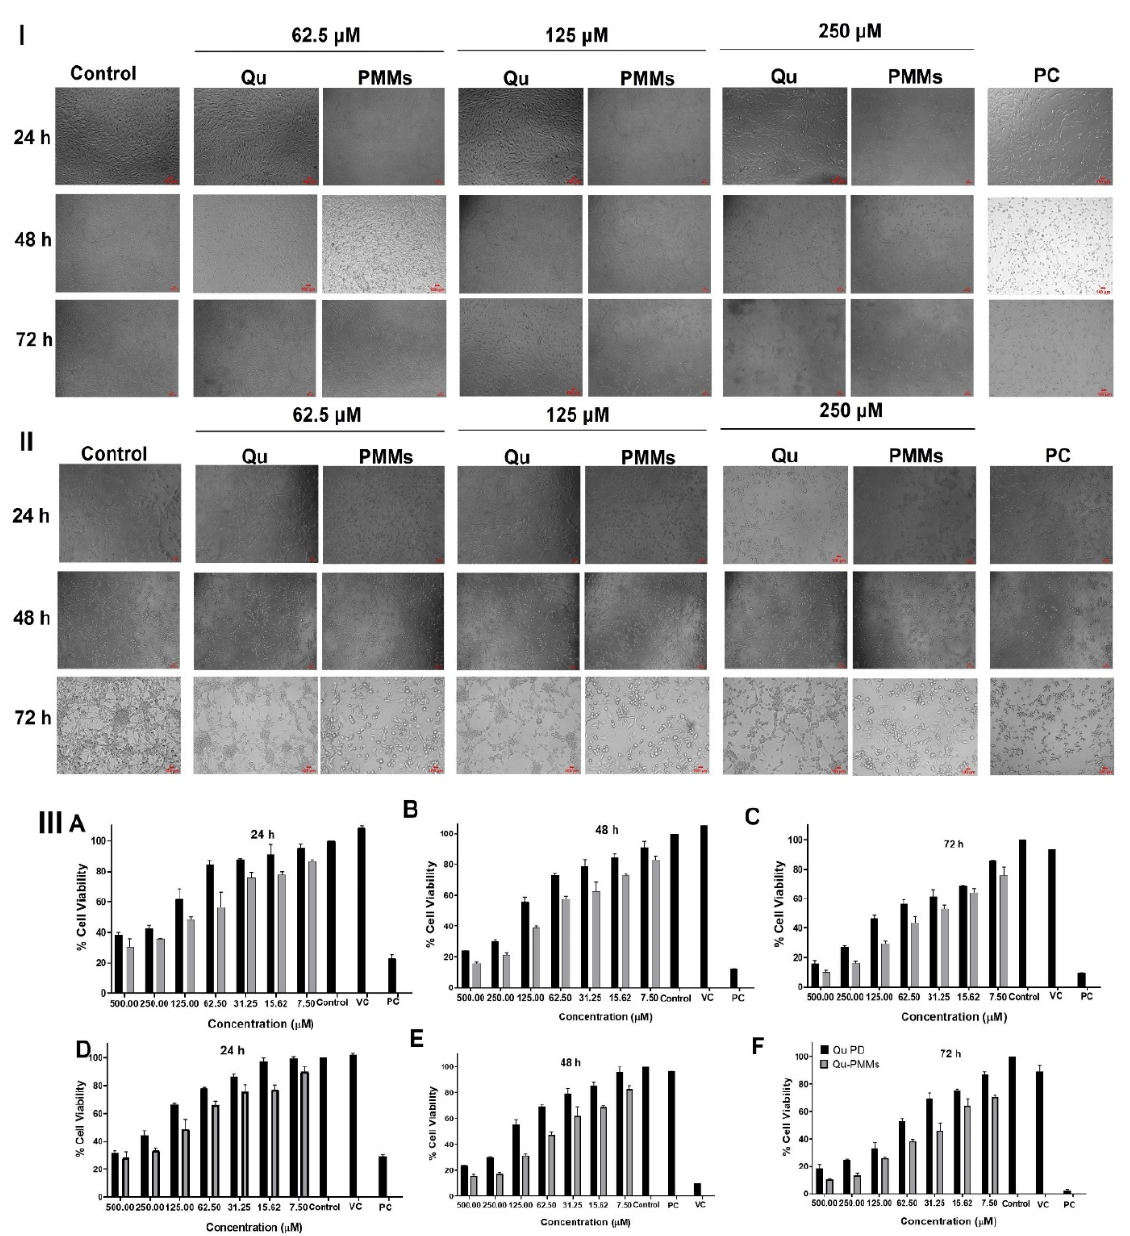
Figure 3. Cell Viability Assay of Qu and Qu-PMMs treatment on C6 and U87MG Cells; Pictorial representation of morphological changes of C6 ( I ) and U87MG ( II ) cells on the treatment of Qu and Qu-PMMs; ( III ) % Cell viability of C6 and U87MG cells treated Qu and Qu-PMMs time (( A , D ) (24 h), ( B , E ) (48 h) and ( C , F ) (72 h)) and dose (7.50, 15.62, 31.25, 62.5, 125, 250, and 500 µ M) dependent studies by using MTT assays. Data are represented in means ± Standard deviation ( n = 3). Scale bar ( A , B ) (10×) 100 μ m.